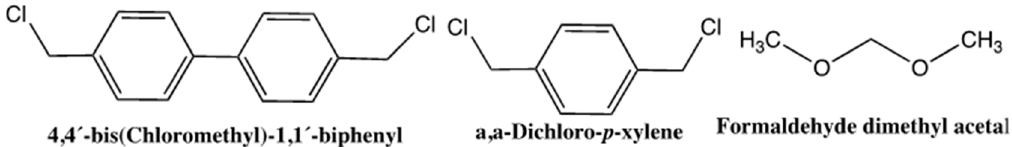
Figure 1. The structure of 4,4’-bis(chloromethyl)-1,1´-bibhenyl, α - α ´-dichloro-p-xylene and formaldehyde dimethyl acetal [16].